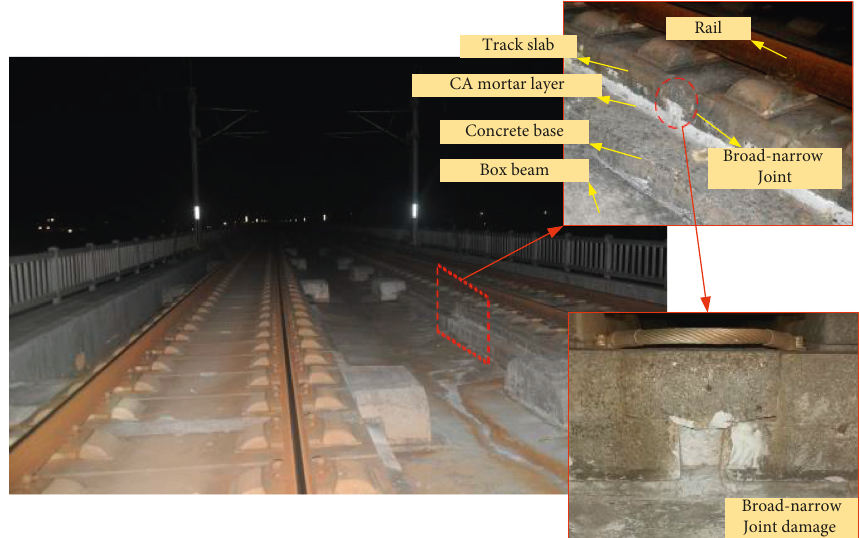
Figure 1: The structure of the CRTS II slab